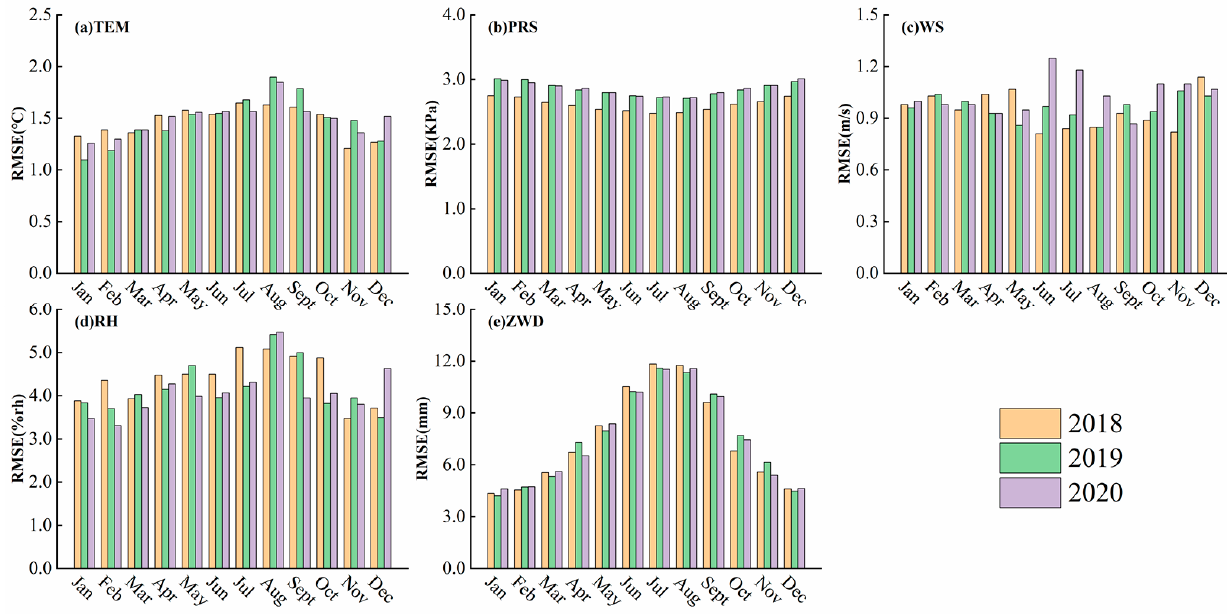
Figure 2. RMSE results of ( a ) TEM, ( b ) PRS, ( c ) WS, ( d ) RH, and ( e ) ZWD for different years and months in the IDW interpolation study area.